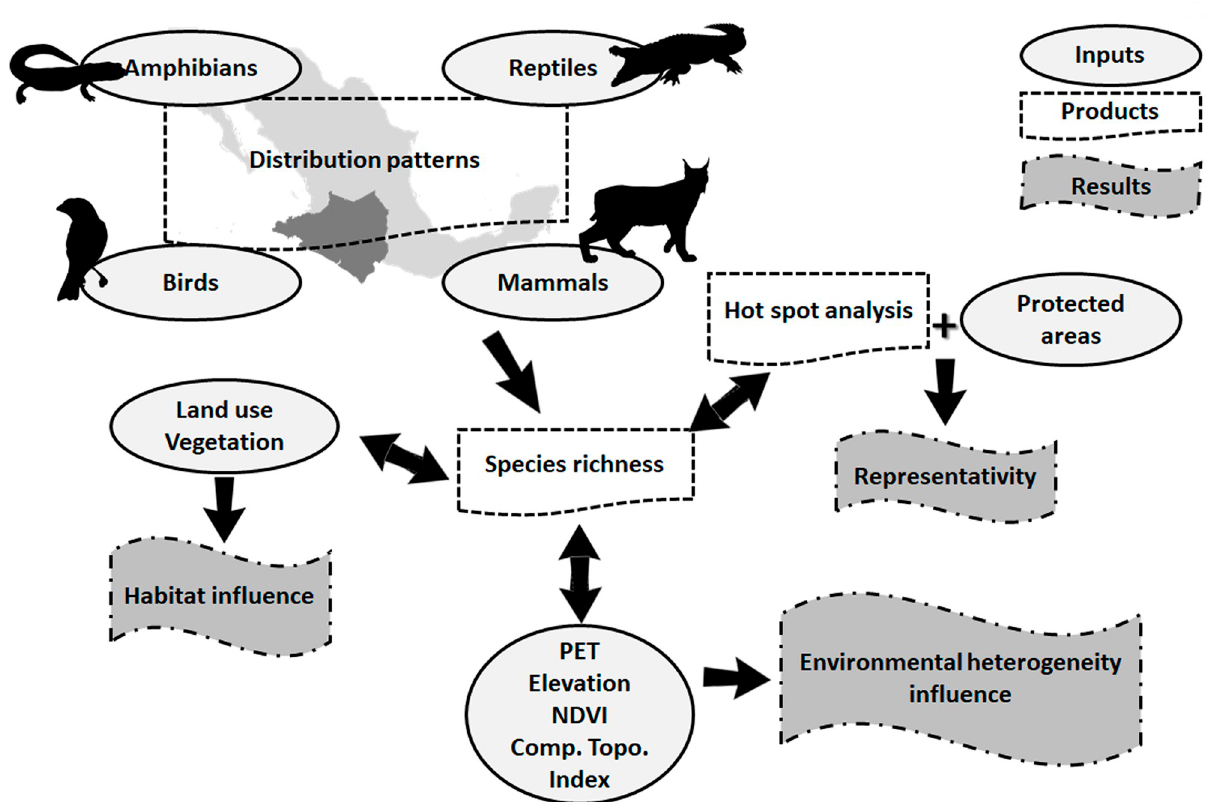
Fig 2. Workflow with the methods and inputs of the manuscript; silhouette imagens taken from PhyloPic (http://phylopic.org).